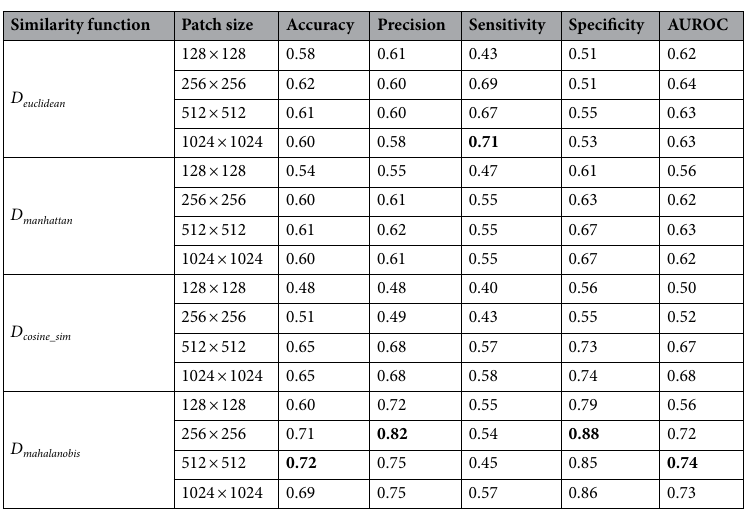
Table 2. Comparison of the performances of single-resolution patch-based anomaly detection.